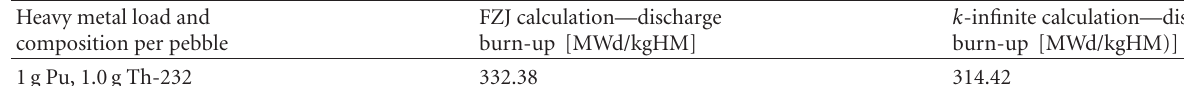
Table 5: Comparison between k -infinite model and FZJ [15] results.